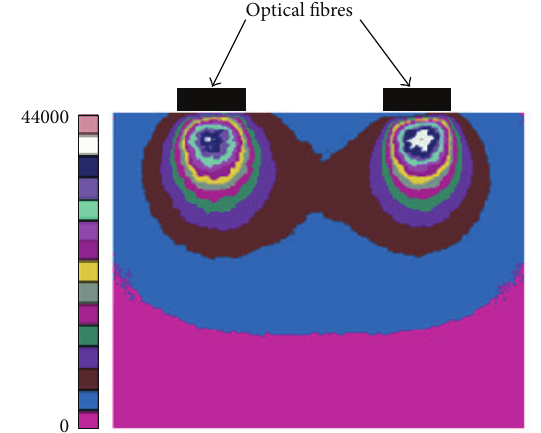
Figure 5: The image of light field distribution obtained by MClight and processed by means of the TiffReader program. Each tone corresponds to its own brightness range which is shown on the left